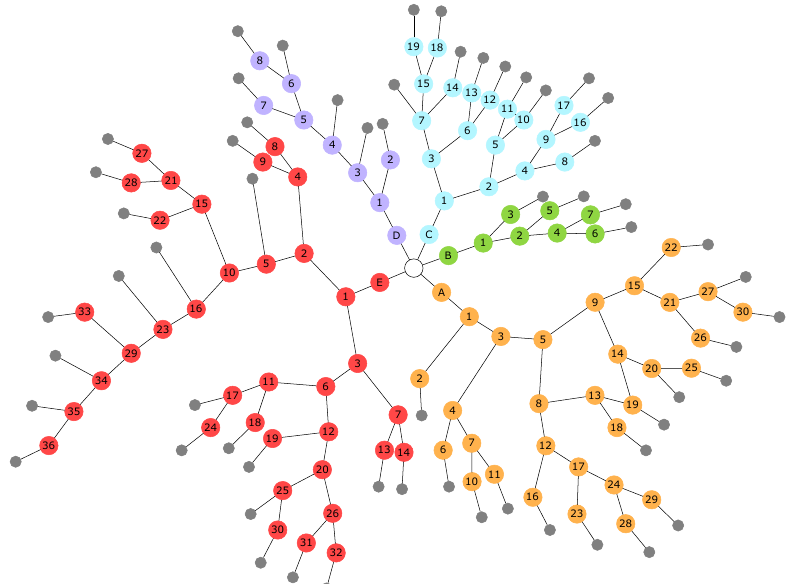
Figure 2. Graphical representation of the questionnaire. Colours indicate the five main branches, corresponding to the possible answers of the first query. Further details are provided in the Additional Material (Appendix A). The reader is referred to the electronic version of the article for interpretation of the colours in this